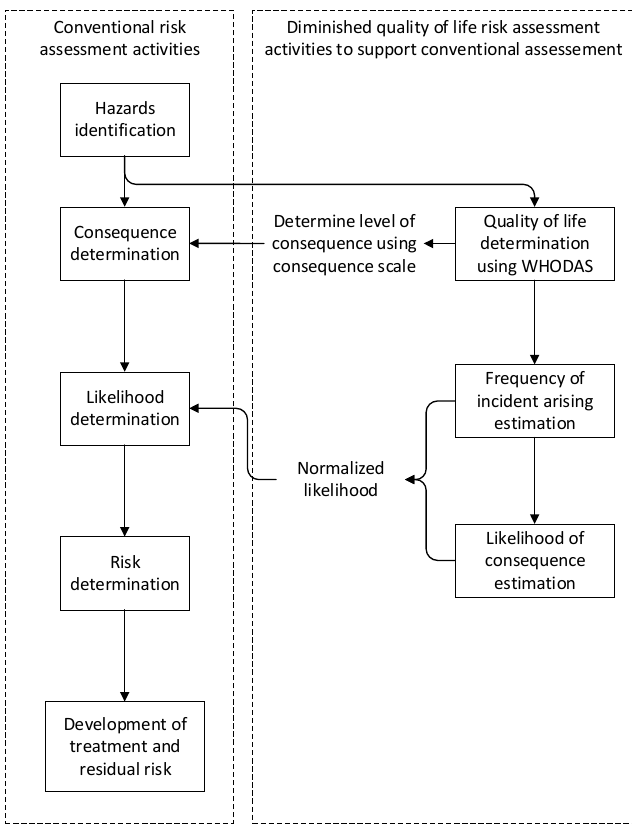
Figure 2. The integration of conventional risk assessment and DQL method.